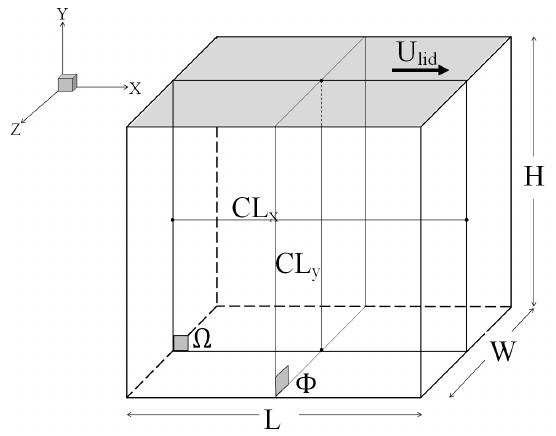
Figure 1. Schematic of a lid-driven cavity in three